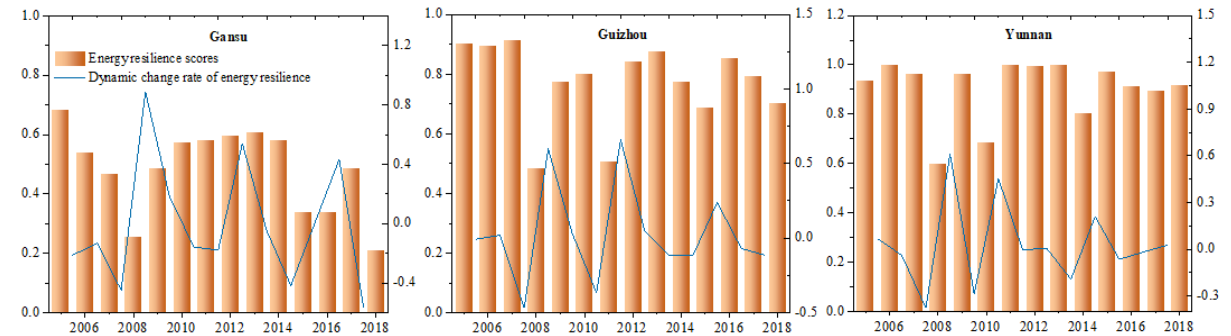
Figure 11. Energy resilience of the top three economically developed provinces in China.